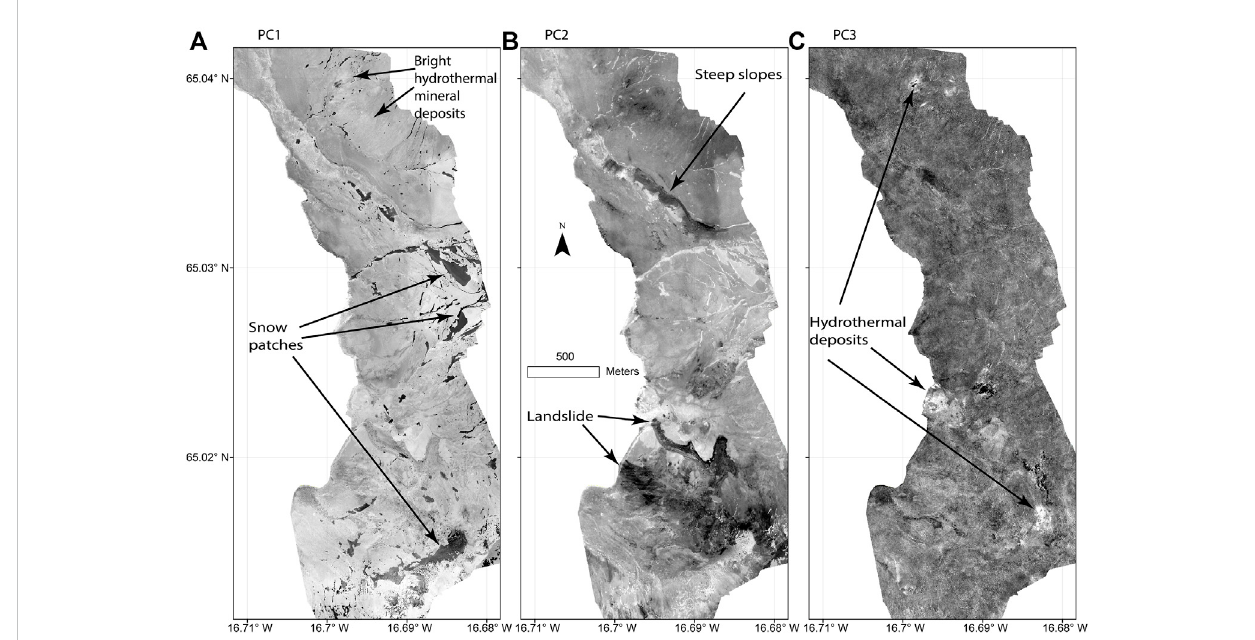
FIGURE 6 Grayscale images of the three principal components obtained from the 2019 drone orthomosaic (from left to right: PC1, PC2, and PC3). (A) Dark- colored areas in PC1 correspond to snow-cover and bright hydrothermal mineral deposits. (B) Landslide area and the steep debris-covered slopes in the Northeastern part of the caldera are accentuated by dark tones in PC2. (C) Note the bright spots in PC3, which mark the locations of the hydrothermally active